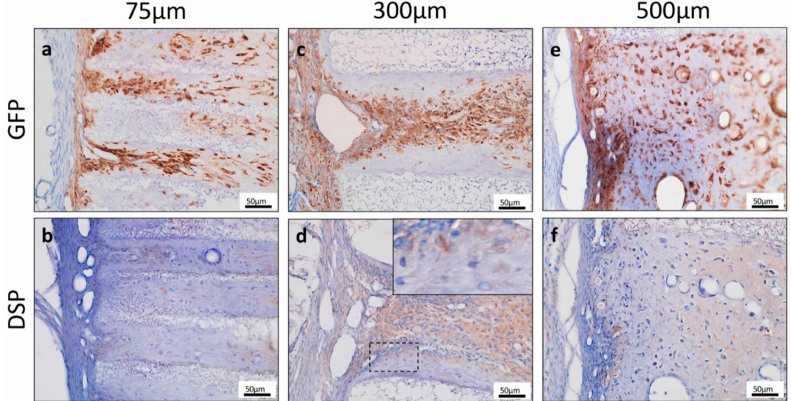
Figure 4. ( a , c , e ) The cells forming hard tissues in the TCP pores were GFP positive. ( b , d , f ) Dentin Sialprotein (DSP) was not expressed in the cytoplasm of cells forming hard tissues in 75TCP and 500TCP. In contrast, in 300TCP, DSP was expressed in the cytoplasm of cells that were arranged with polarity on the TCP wall.